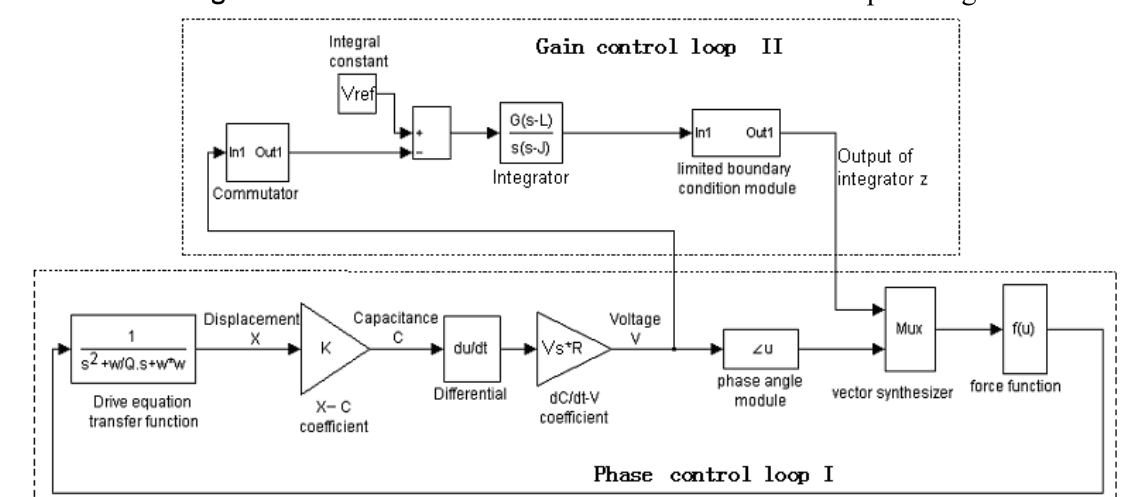
Figure 4. The Matlab simulation frame of the closed-loop driving.